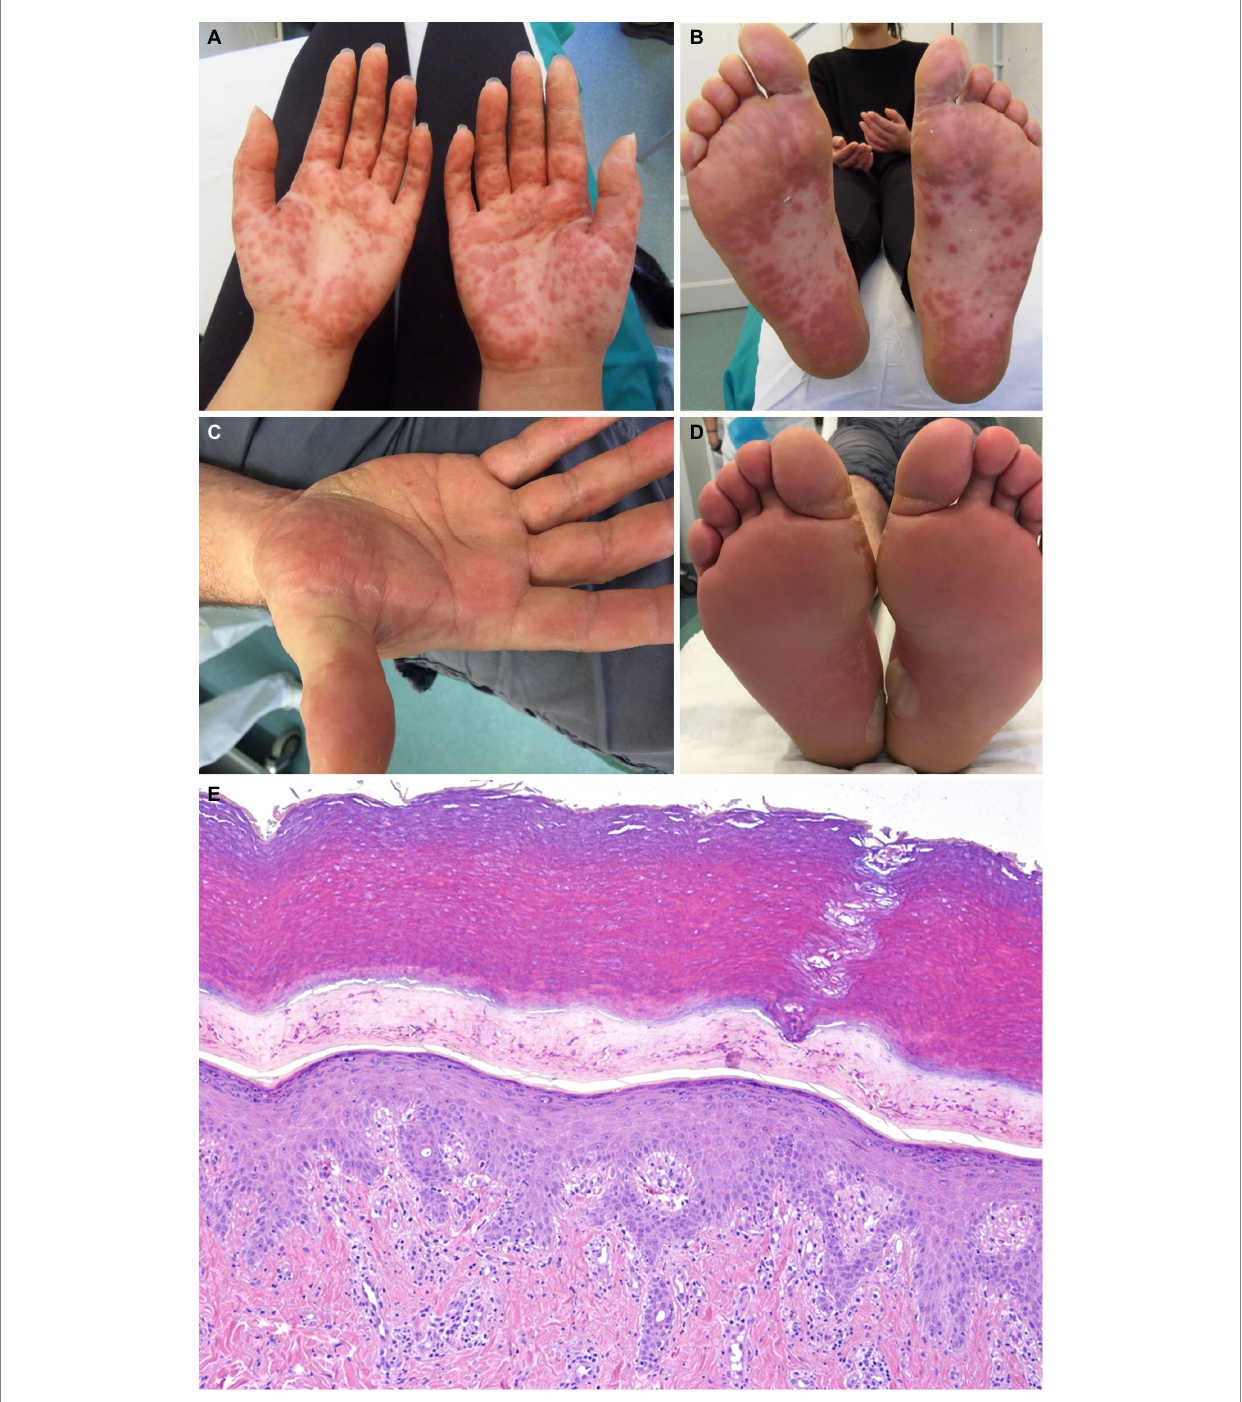
FIGURE 3 Patient 7 (A,B) and Patient 8 (C,D) . Erythematous maculopapular eruption involving the palms and the soles. Blisters are evident on the soles of patient 8 (D) . The histopathological sample from patient 7 shows epidermal spongiosis and an interstitial and perivascular lymphocytic infiltrate in the dermis (hematoxylin-eosin, x40) (E)